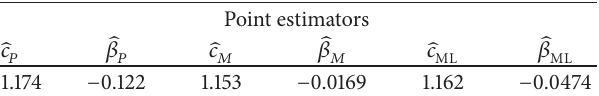
Table 7: Estimates of the parameters of the discrete Weibull for the second example